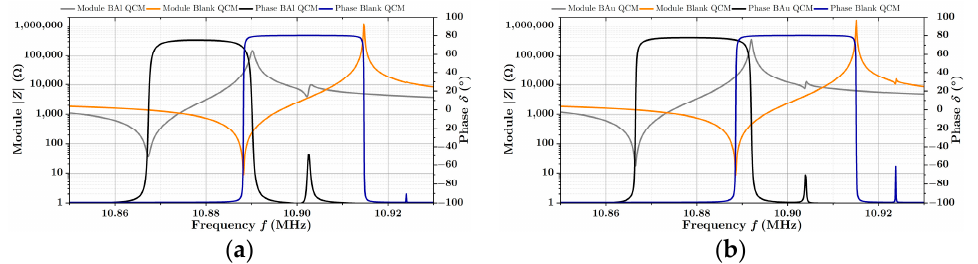
Figure 5. Impedance spectrum of QCM sensors before and after coating with B-Al layer in ( a ) and before and after coating with B-Au layer ( b ). Table 2. Equivalent circuit parameters for QCM with B-Al layer.